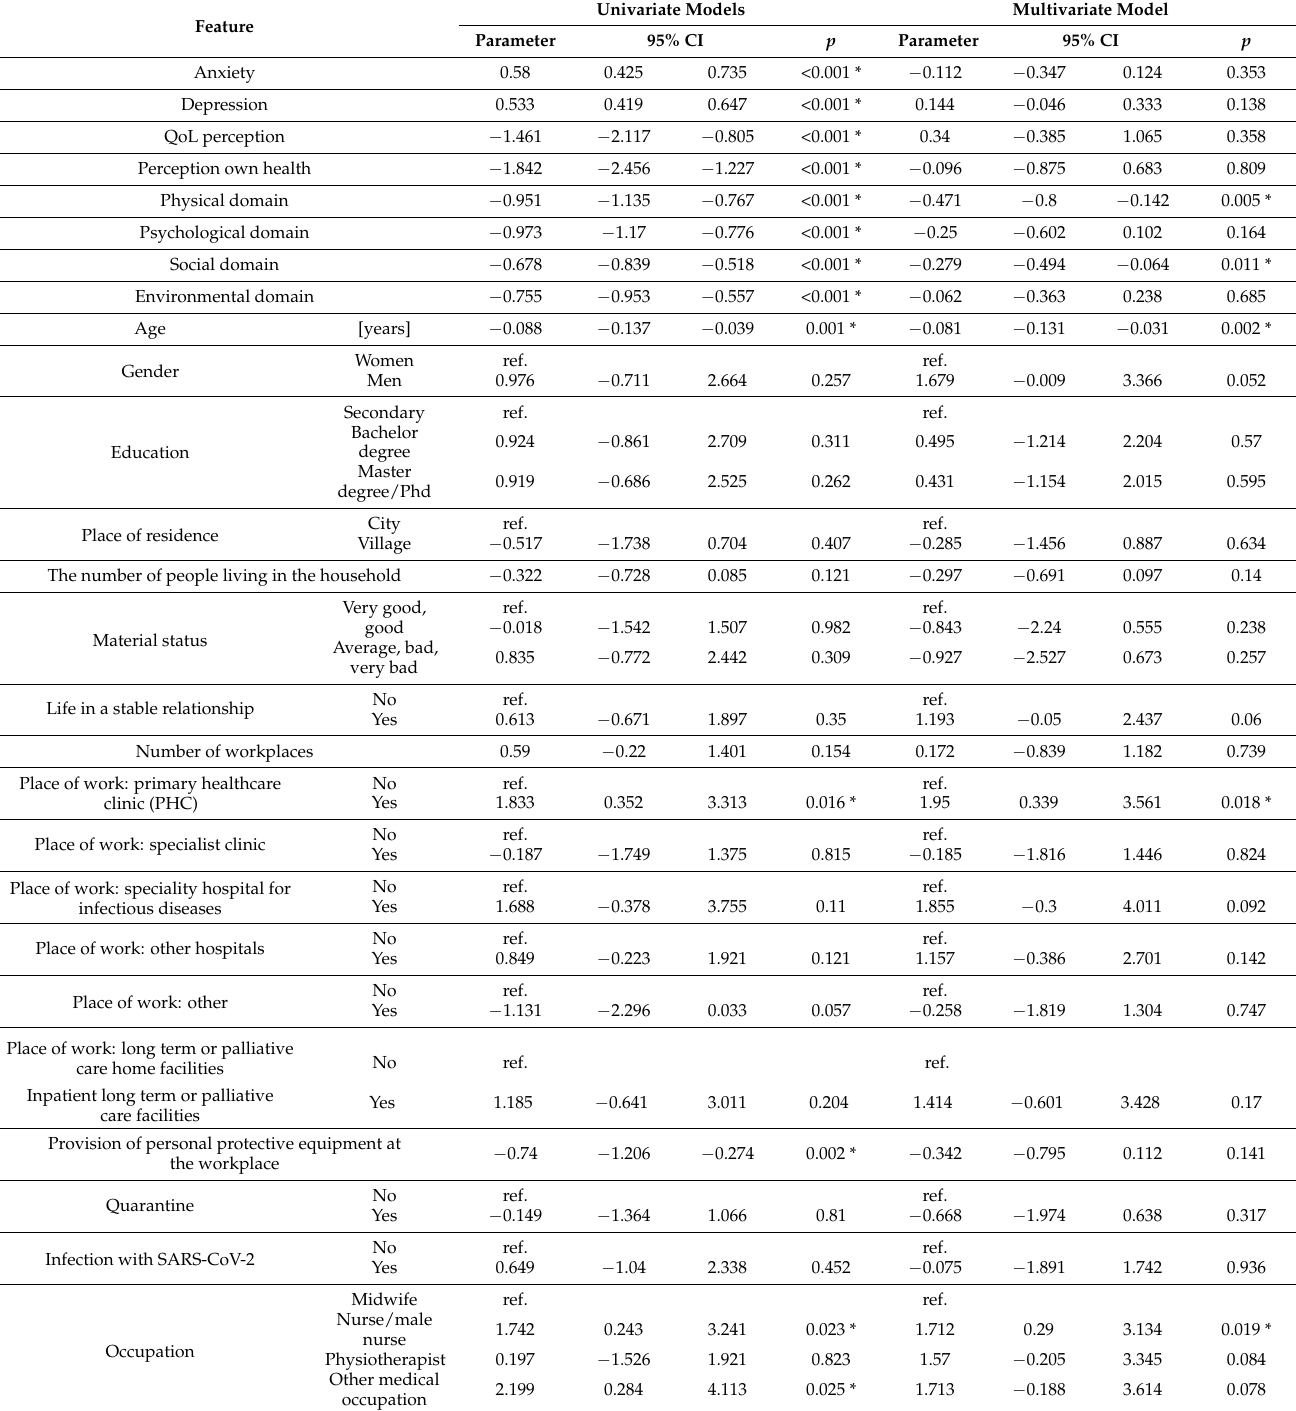
Table 5. Depersonalization–mono- and multifactorial regression